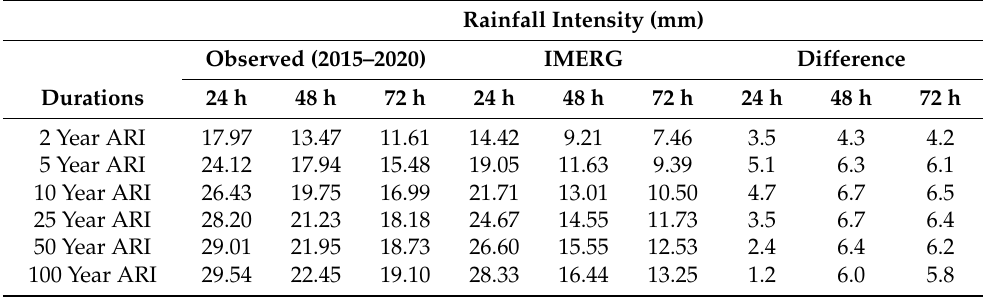
Table 6. Observed and IMERG rainfall intensity for different durations and return periods and their